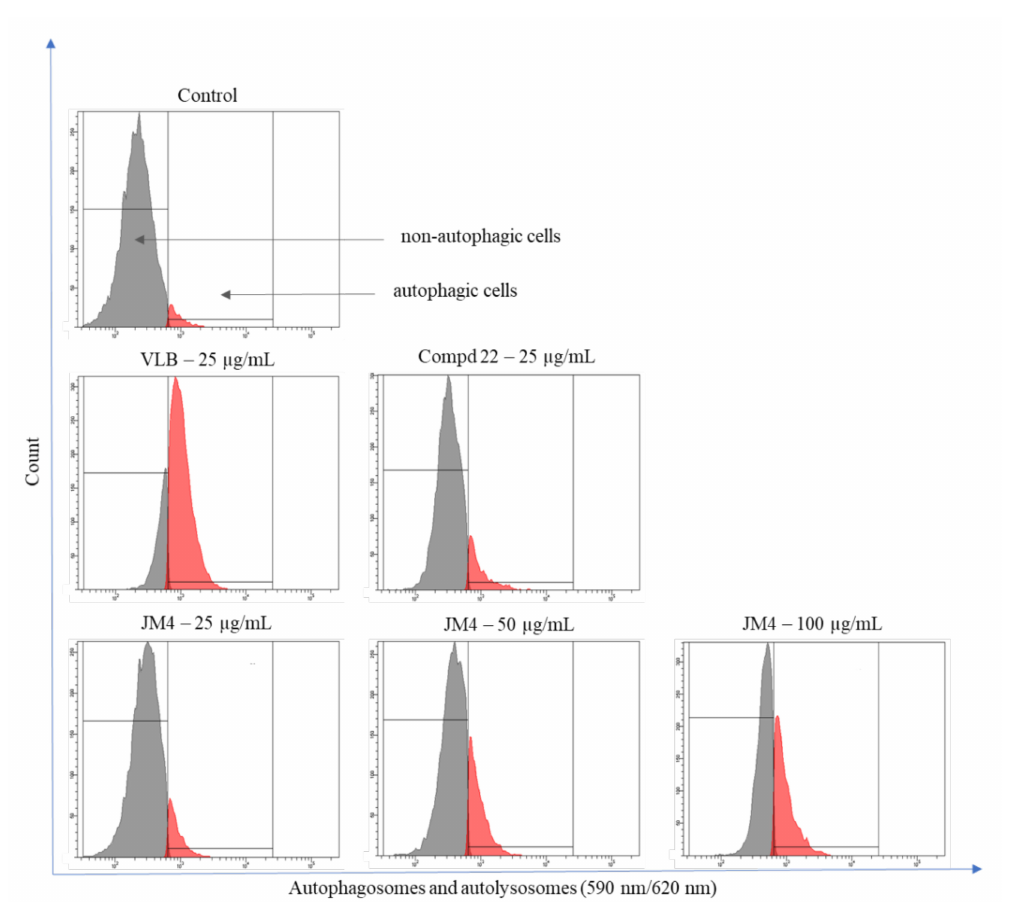
Figure 7. Autophagy induction in C32 melanoma cells measured by flow cytometry using Autophagy Probe (right—red histogram) compared to negative control cells (left—gray histogram) after 24 h incubation with JM4 (25, 50, 100 µ g/mL), 22 (25 µ g/mL) and vinblastine sulfate (VLB) (25 µ g/mL).